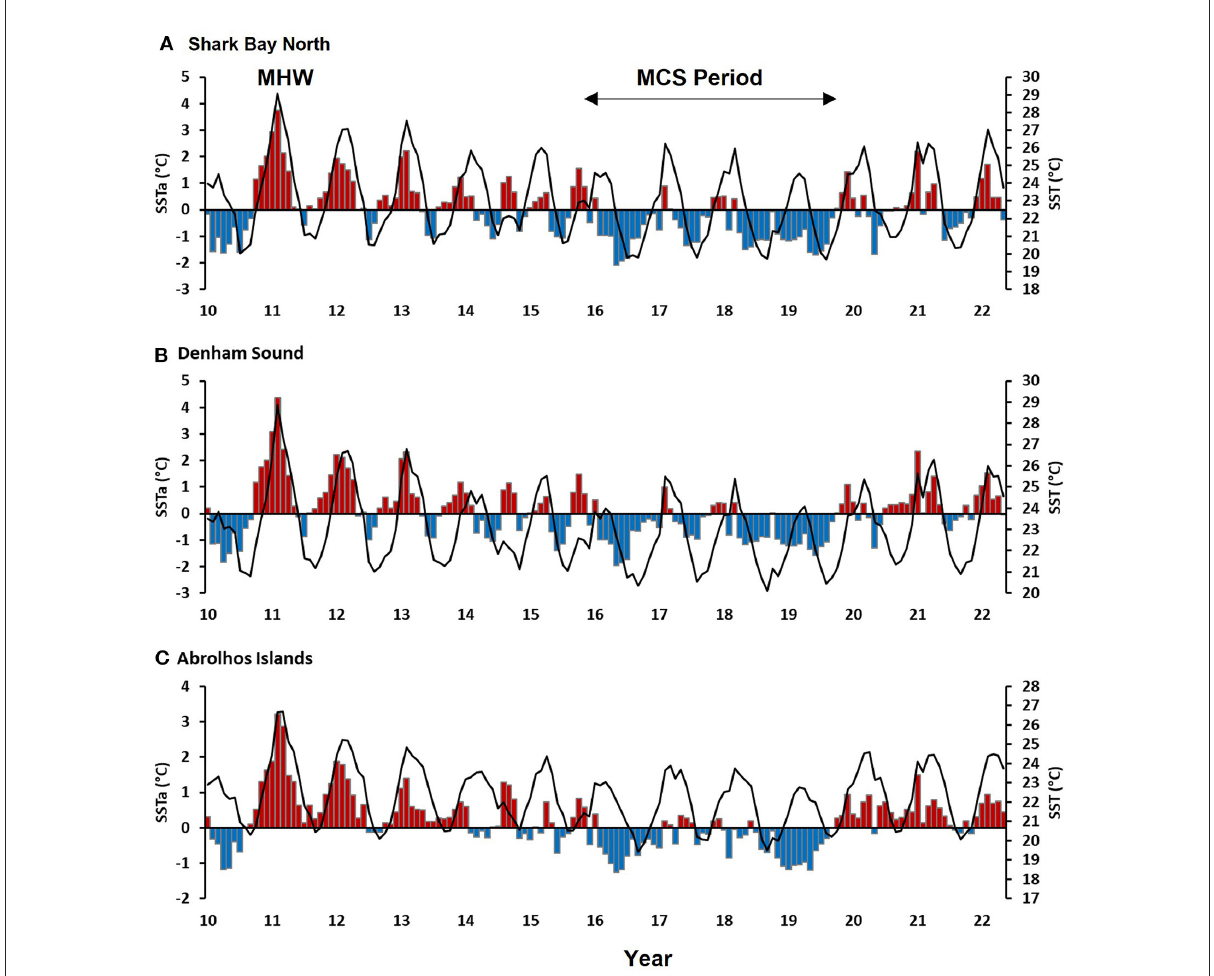
FIGURE3 Mean monthly SST (line) and SST anomalies (red and blue bars) from 2010 to 2022 against a climatology of 1981–2018 for (A) Shark Bay North (B) Denham Sound and (C) Abrolhos Islands. The 2011 marine heatwave (MHW) and 2016-19 marine cold spell (MCS) are indicated.